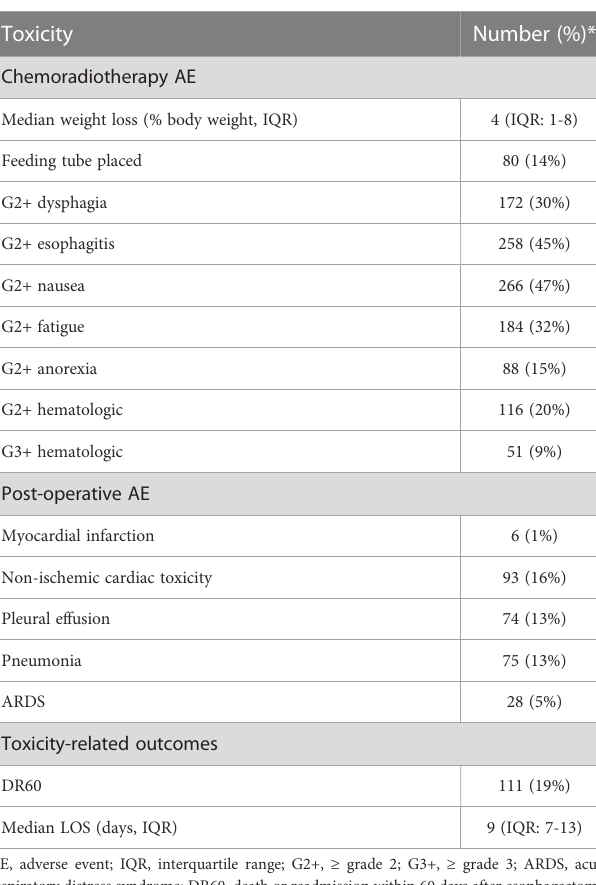
TABLE 3 Treatment related adverse